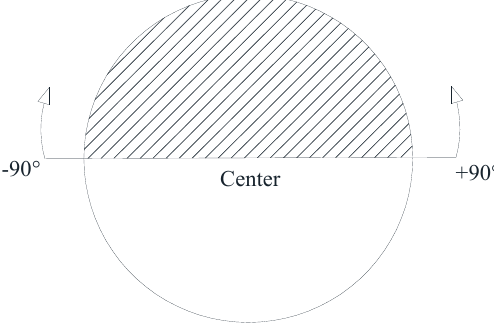
Figure 10. The area on a bubble that easily collides with glass microspheres.